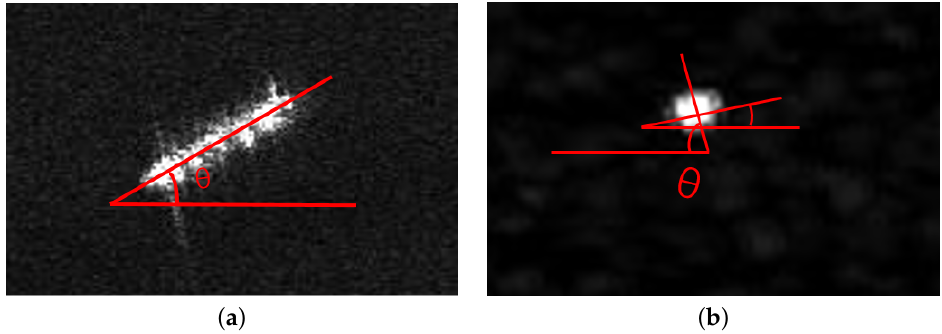
Figure 4. Two SAR ship instances with different shapes. ( a ) Ship with a big aspect ratio presents an obvious orientation; ( b ) square-like ship presents an obscure